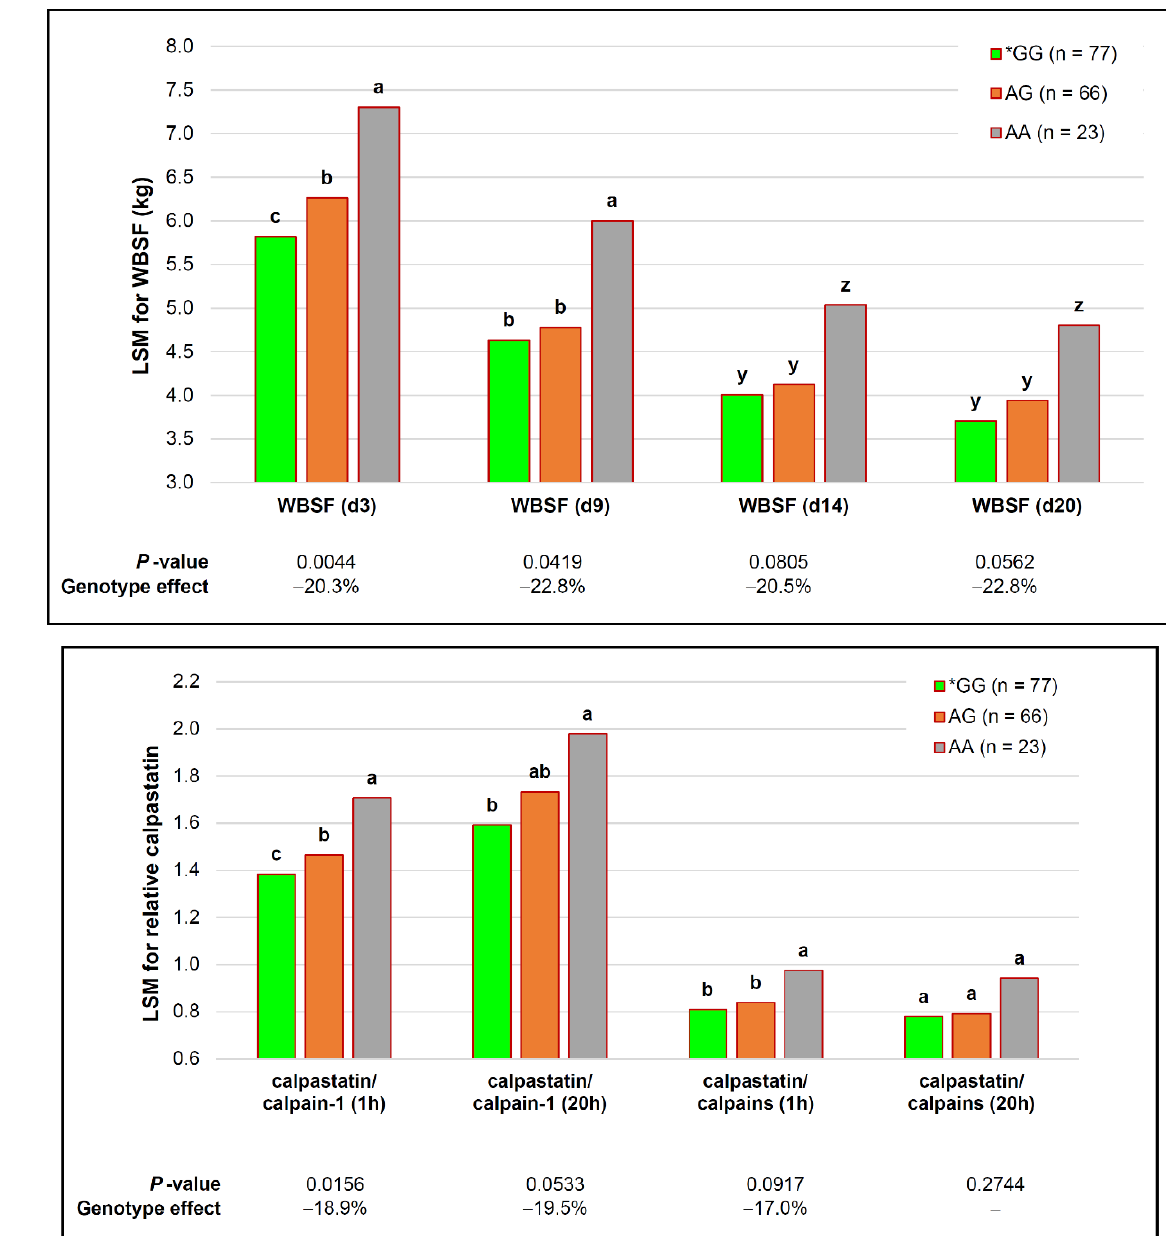
Figure 3. Additive effects of the capn1_184 genotype and ageing on tenderness in representative purebred South African beef bulls. * GG—the genotype that favored tenderness. Within each ageing period, different ascending letter superscripts (a, b, c) were significantly different ( p ≤ 0.05), and those that tended to be different ( p ≤ 0.10) were indicated with different descending letter superscripts (z, y, x): ( a ) Warner–Bratzler shear force (WBSF); the effect on d 20 was not significant after FDR adjustment (adjusted p ≤ 0.1250); ( b ) relative calpastatin inhibition of protease(s).